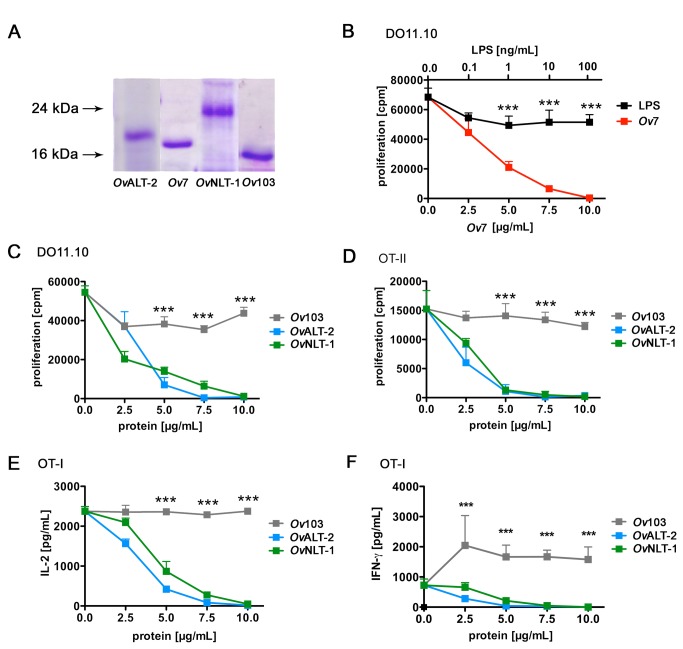
Nematode-derived ESP suppress OVA-specific T cell function.A) Coomassie blue-staining of recombinant proteins after purification and
separation by SDS-PAGE. B) Spleen cells from TCR transgenic DO11.10 (B,
C), OT-II (D) or OT-I (E, F) mice were stimulated with 10 ng/mL
OVA323-339 (B-D) or OVA257-264 (E, F) peptide
in the presence of ESP or LPS in increasing concentrations as indicated
on the x-axis. OVA-specific proliferation of DO11.10 (B, C) and OT-II
(D) T cells was measured after 72 h as 3H-thymidine
incorporation. IL-2 (E) and IFN-γ (F) secretion by OT-I T cells was
analyzed by ELISA. Error bars show SD of triplicates. Data shown are
representative for five (B, C) or two (D, E, F) independent experiments.
Asterisks indicate significant differences in the mean of
Ov103 or LPS to Ov7 or
OvALT-2 or OvNLT-1 (*** p <
0.001).